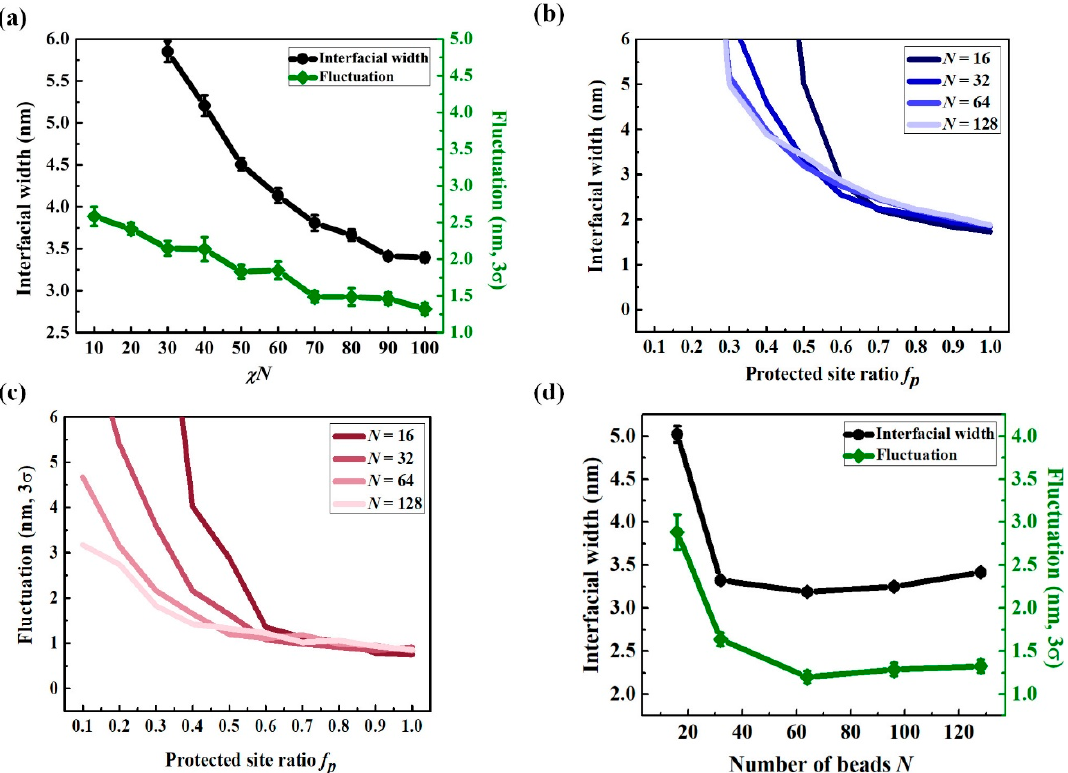
Figure 4. Interfacial width and fluctuation of the interface positions after the PEB process; ( a ) interfacial width and fluctuation as a function of the repulsion degree 𝜒𝑁 at fixed N = 128 and f p = 0.5, ( b ) interfacial width as a function of the protected site ratio of four different N s at fixed 𝜒 = 0.78, ( c ) fluctuation as a function of protected site ratio f p of four different Ns at fixed 𝜒 = 0.78, and ( d ) interfacial width and fluctuation as a function of N at fixed f p = 0.5 and 𝜒 = 0.78.